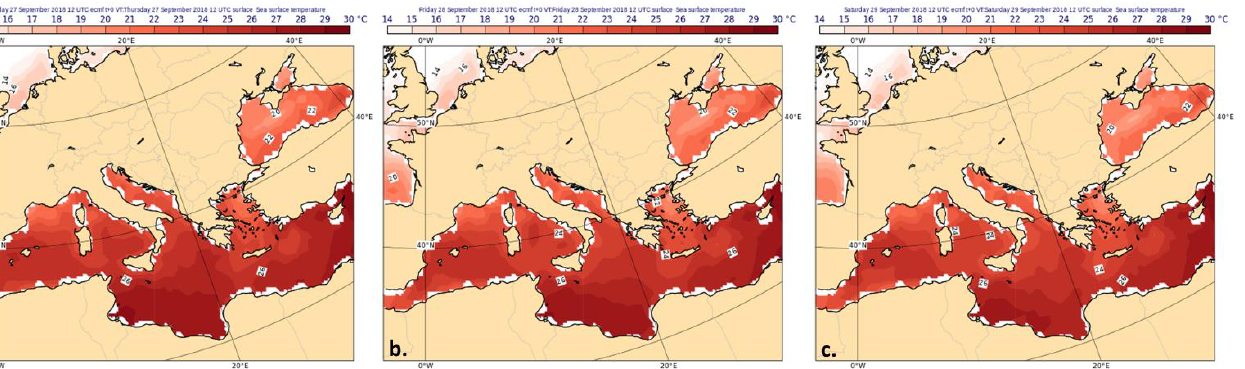
Figure 10. Q-vectors (units s − 3 and scaling ×10 11 ), potential temperature (coloured areas; in K), and geopotential height (continuous lines; in gpdam) at 700 hPa for 27/12 UTC.